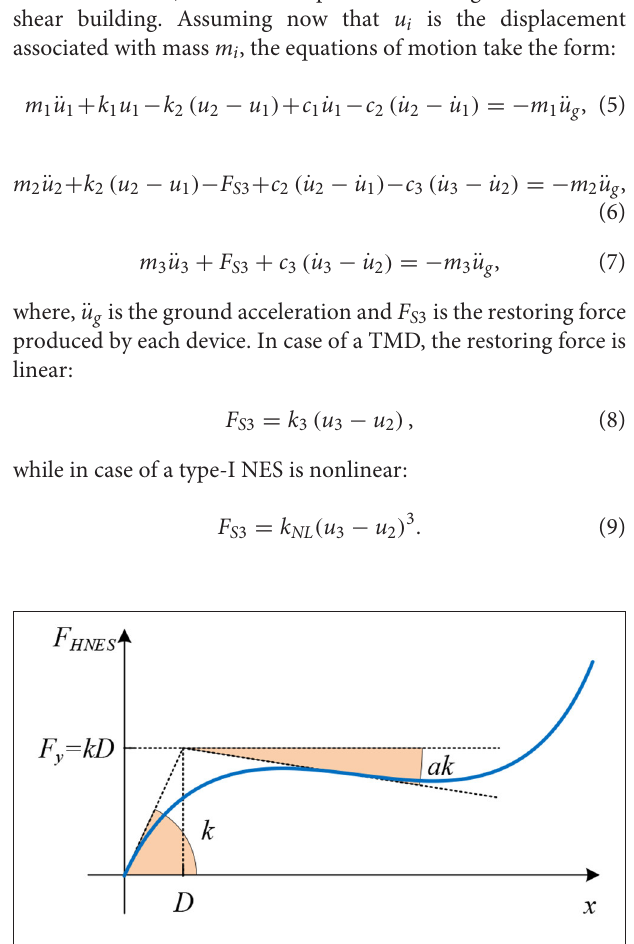
FIGURE 5 | Combined response of HNES springs under displacement-controlled monotonic